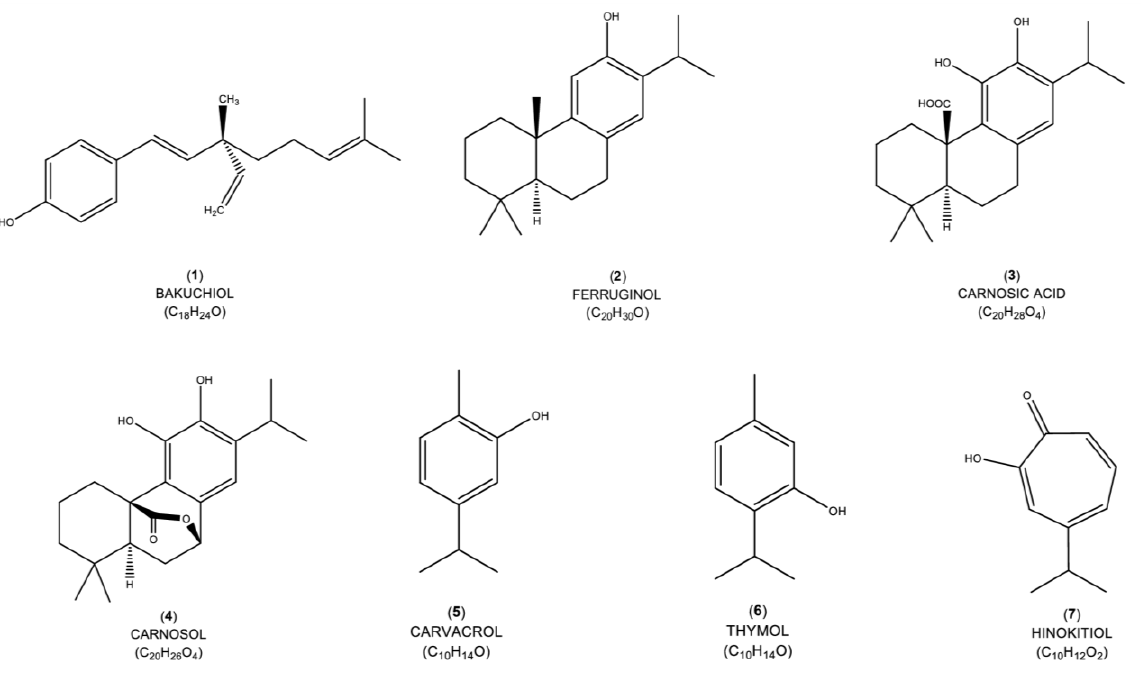
Figure 2. Chemical structures of the terpenophenolic compounds with potential to be used in the development of novel medications to treat cardiovascular diseases.